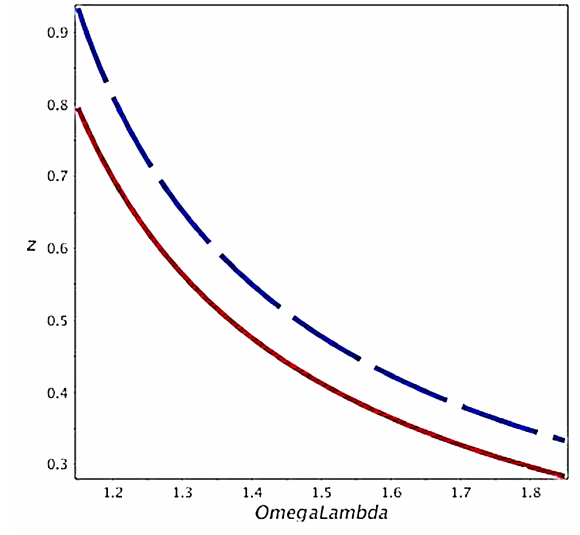
Figure 4. The exact solution for the zero in E(z), full red line, and Padé approximated solution, dashed blue line, when Ω K (cid:16)